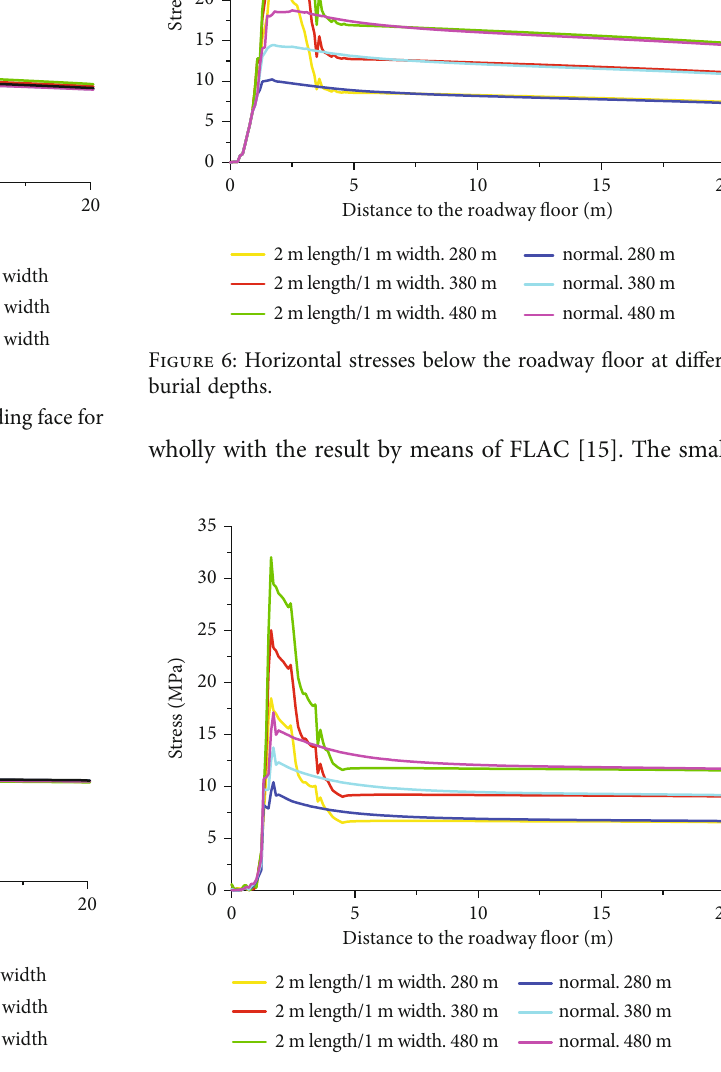
Figure 7: Vertical stresses below the roadway fl oor at di ff erent burial depths.